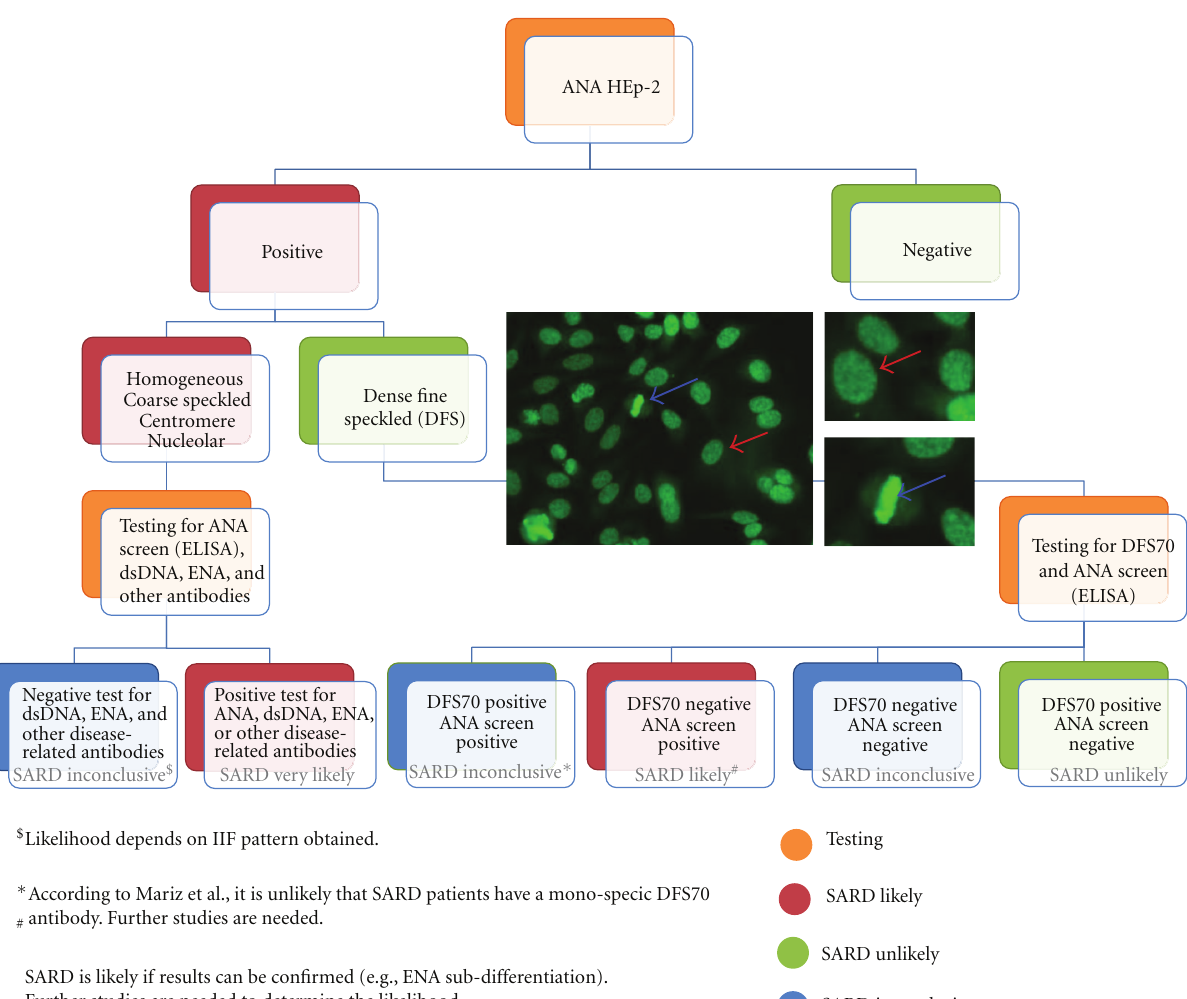
Figure 4: Characteristic staining pattern and suggested test algorithm considering anti-DFS70 antibodies. The characteristic dense fine speckled (DFS) staining pattern of interphase cells is indicated by the red arrow and the strong chromosome staining of metaphase cells by the blue arrow. Samples with a DFS pattern should be tested for anti-DFS70 antibodies by a confirmatory test and by ANA Screen ELISA (QUANTA Lite ANA Screen ELISA) containing various autoantigens. Patients with negative ANA Screen ELISA and positive DFS70 result have a low likelihood for having SARD. Patients with a positive ANA Screen ELISA either in combination with a positive or a negative DFS70 test result have an increase likelihood of having